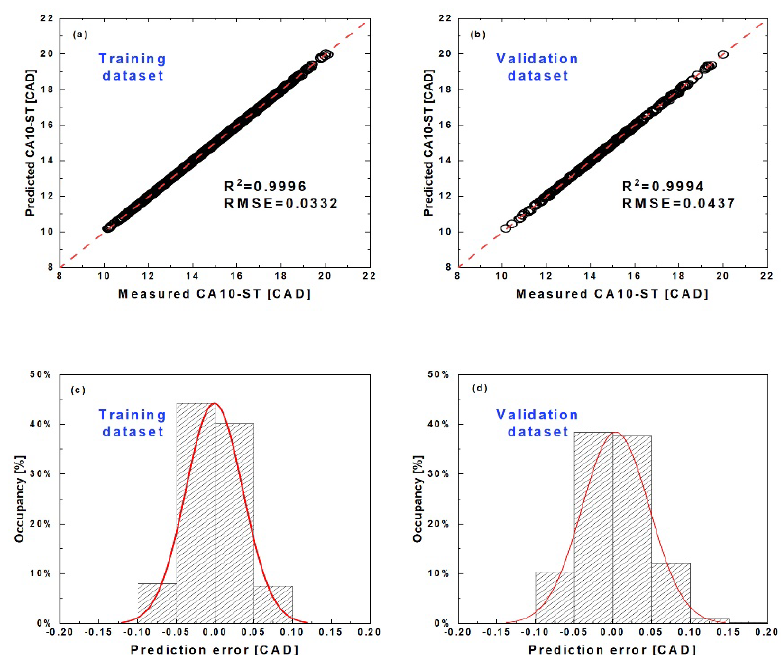
Figure 7. Comparison of predicted CA10 − ST with the measured data. ( a ) Prediction performance of training dataset; ( b ) prediction performance of validation dataset; ( c ) prediction error of training dataset; and ( d ) prediction error of validation.